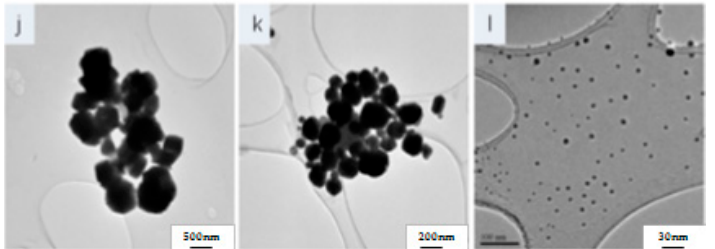
Figure 1. ( a ) Sample S1, Spherical nanoparticles (90 nm); ( b ) Sample S2, Combination of spheres and rods; ( c ) Sample S3, Combination spheres and rods with predominant rods; ( d ) Sample S4, Rod-like nanoparticles; ( e ) Sample S5, Cubic-shaped nanoparticles; ( f ) Sample S6, Pyramidal nanoparticles; ( g ) Sample S7, Irregular spherical particles; ( h ) Sample S8, Combination of neogeometrical nanoparticles; ( i ) Sample S9, Combination of neogeometrical nanoparticles at reduced size range; ( j ) Sample S10, Irregular nanospheres; ( k ) Sample S11, Spherical nanoparticles (250–300 nm); and ( l ) Sample S12, Spherical nanoparticles (10 nm).